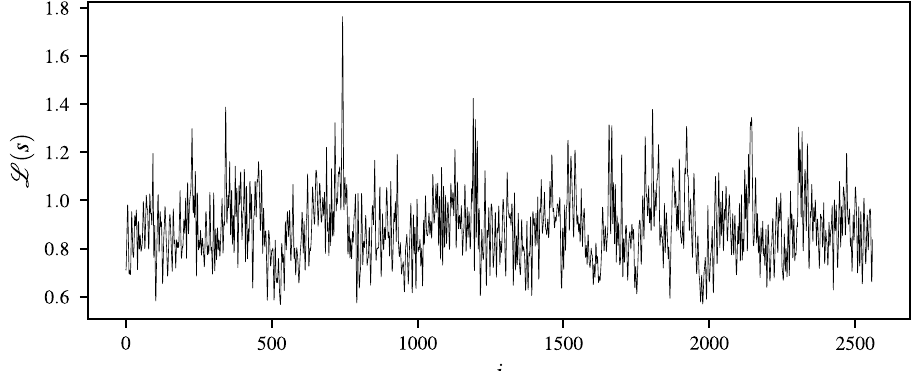
Figure 2. Plot of Lehmer transform against time.